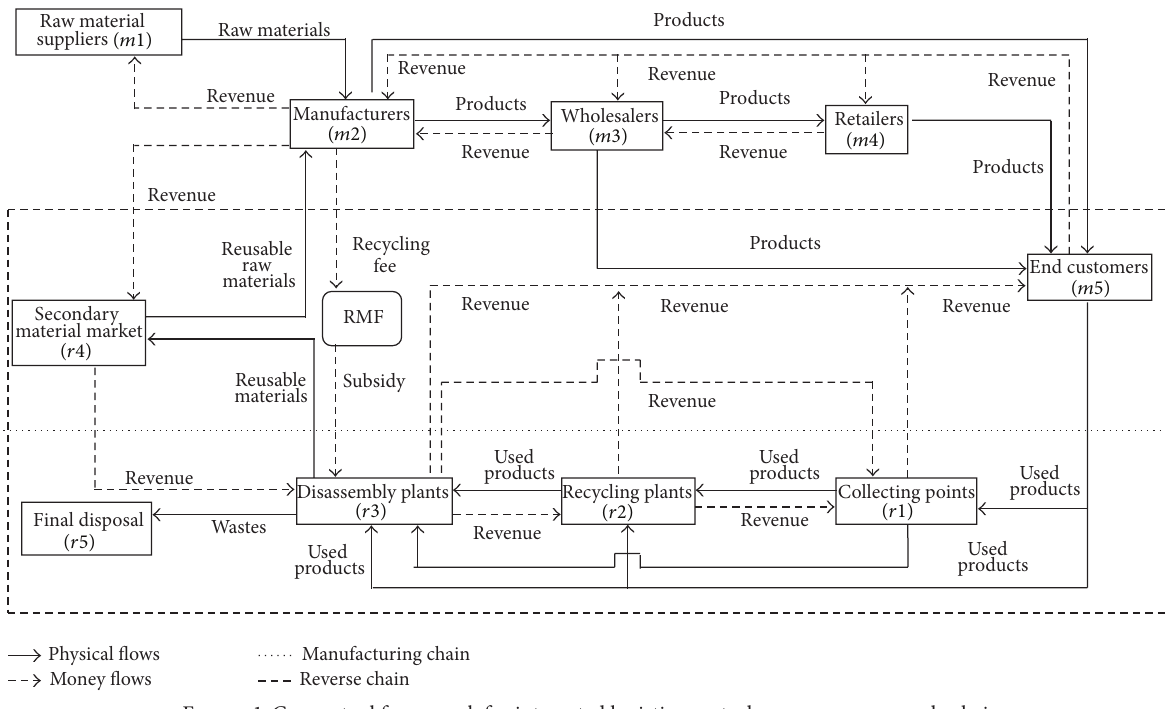
Figure 1: Conceptual framework for integrated logistics control across a green supply